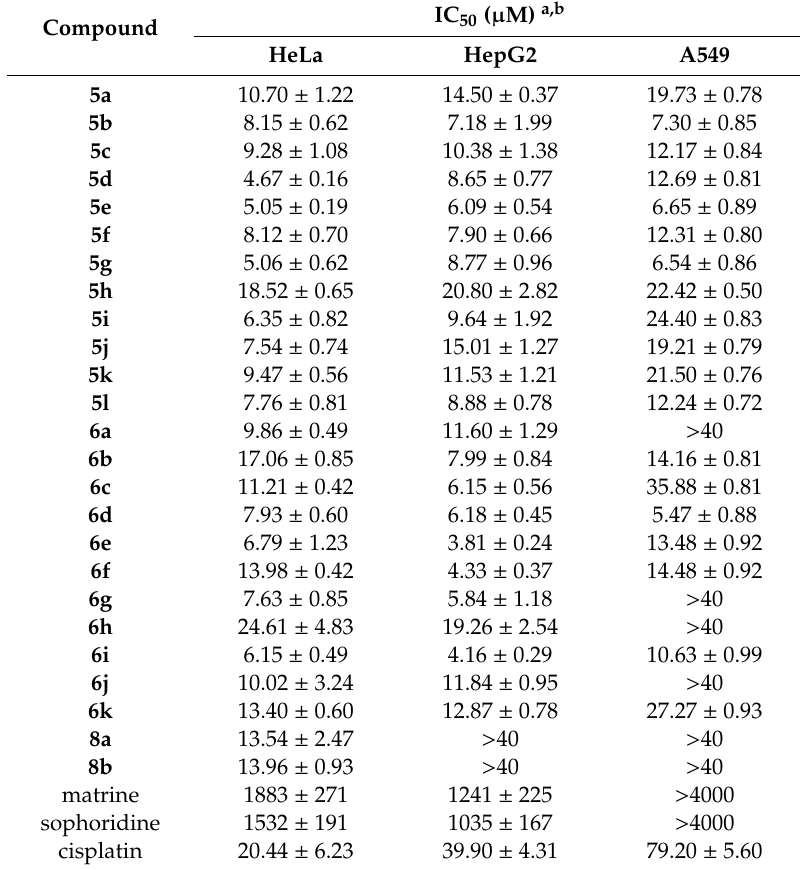
Table 2. Antiproliferative activity of the synthesized derivatives against HeLa, HepG2, and A549 cells.